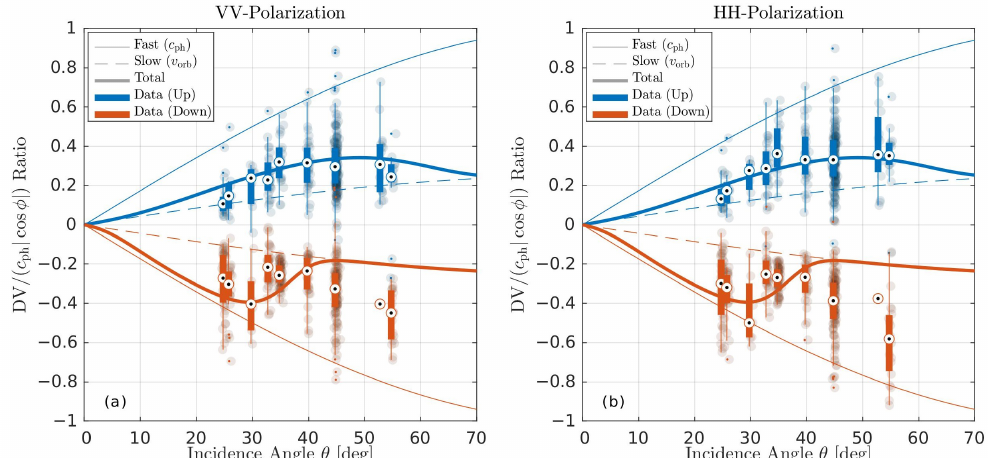
Figure 9. The normalized Doppler velocity, DV/ ( c ph | cos φ | ) , versus the incidence angle, θ , for ( a ) VV and ( b ) HH polarization. The “averaged” dataset is used (each point is a separate breaking event). Cross-wave events with 45 ◦ < φ < 135 ◦ are excluded to avoid noise due to dividing by near-zero LOS projections. The boxplot symbols indicate the average value and standard deviation for a particular incidence angle. The thin lines indicate limiting normalized speeds corresponding to: ( solid ) breaking wave phase velocity—fast scatterers; ( dash ) breaking wave orbital velocity with 0.25-steepness—slow scatterers. The bold lines show the speculative model